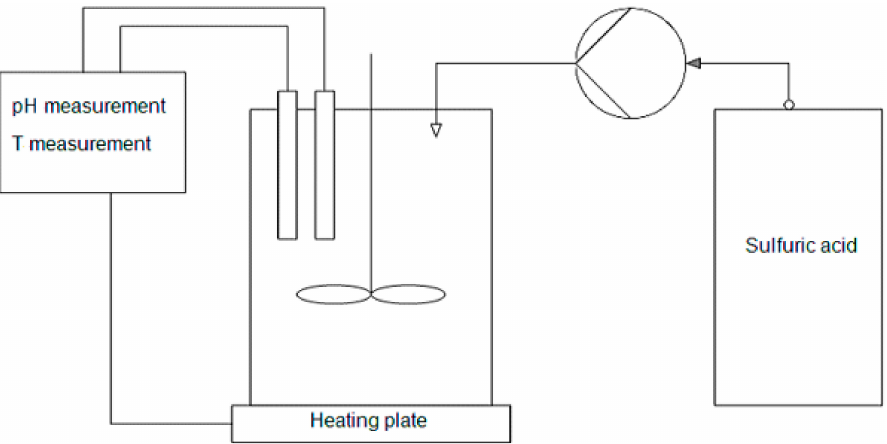
Figure 1. Experimental setup used in the acid consumption test. A 5 L reactor (Ti, Gr. 2) on the heating plate is placed on top of the balance. Titrator is on the